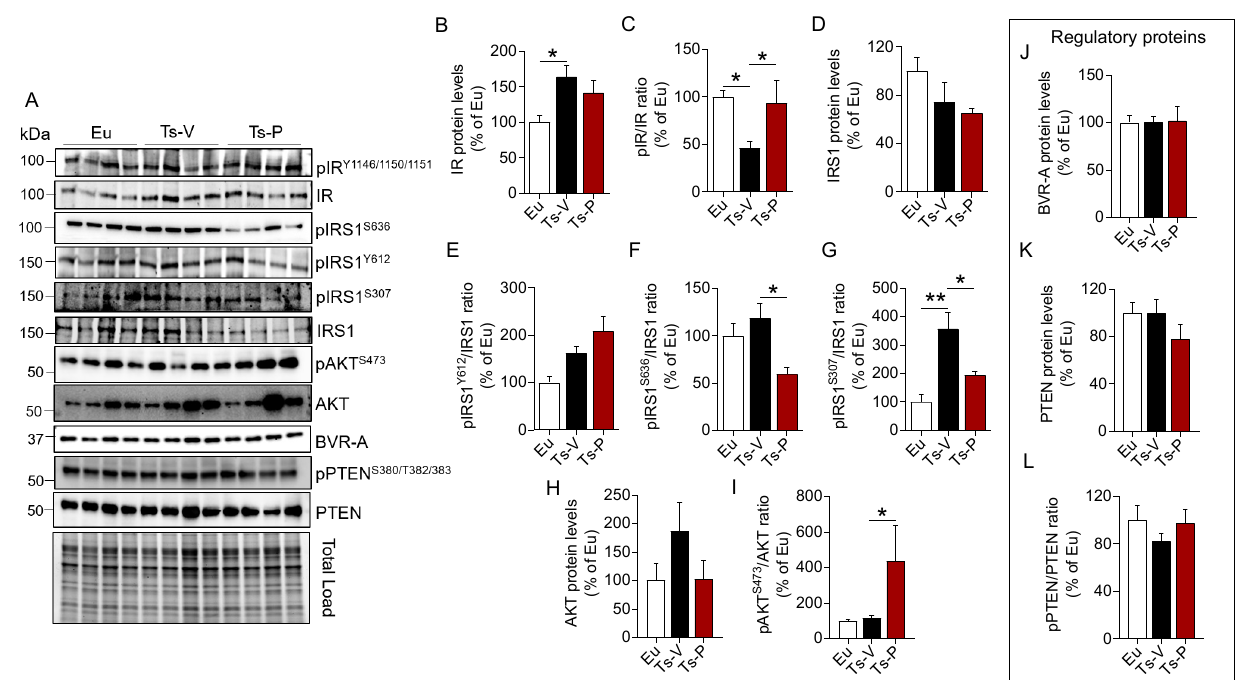
Figure 1. Activation of insulin signaling following KYCCSRK intranasal administration in Ts2Cje mice. IR, IRS1, AKT, BVR-A, and PTEN protein levels and phosphorylation were evaluated in the frontal cortex of Eu and Ts2Cje (Ts-V) mice treated with vehicle (saline) and Ts2Cje (Ts-P) treated with KYCCSRK peptide (0.5 mM) for two weeks (n = 4/group). ( A ) Representative Western blot and total load images and densitometric evaluation of ( B , C ) IR protein levels and activation [evaluated as pIR Y1146/1150/1151 /IR ratio], ( D ) IRS1 protein levels, ( E ) IRS1 activation evaluated as pIRS1 Y612 /IRS1 ratio], ( F , G ) IRS1 inhibition [evaluated as pIRS1 S636 /IRS1 and pIRS1 S307 /IRS1 ratio], ( H , I ) AKT protein levels and activation (evaluated as pAKT S473 /AKT ratio), ( J ) BVR-A protein levels, and ( K , L ) PTEN protein levels and inhibition (evaluated as pPTEN S380/T382/383 /PTEN). All densitometric values were normalized per total protein load and are given as a percentage of Eu set as 100%. Data are shown as mean ± SEM. One-way ANOVA with Dunnett test: * p < 0.05, ** p <